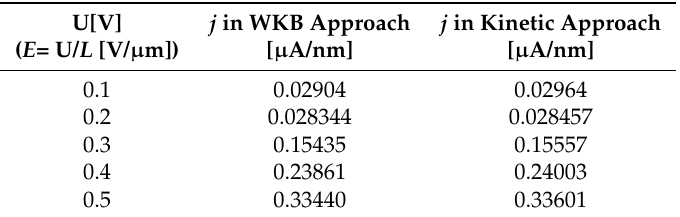
Table 1. Comparison of calculated current density values for a sample with L = 1.0 µ m in the range of potential differences from 0.1 V to 0.5 V.